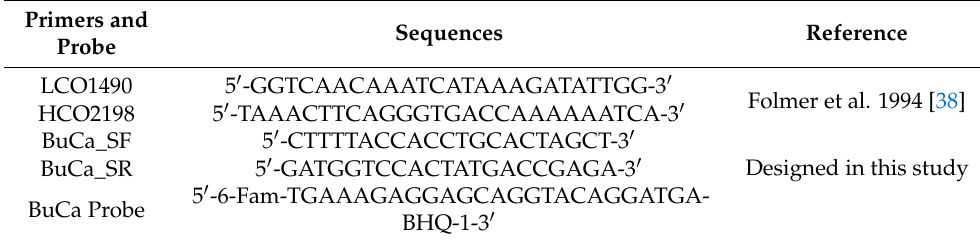
Table 2. Information of primers and probe used in this